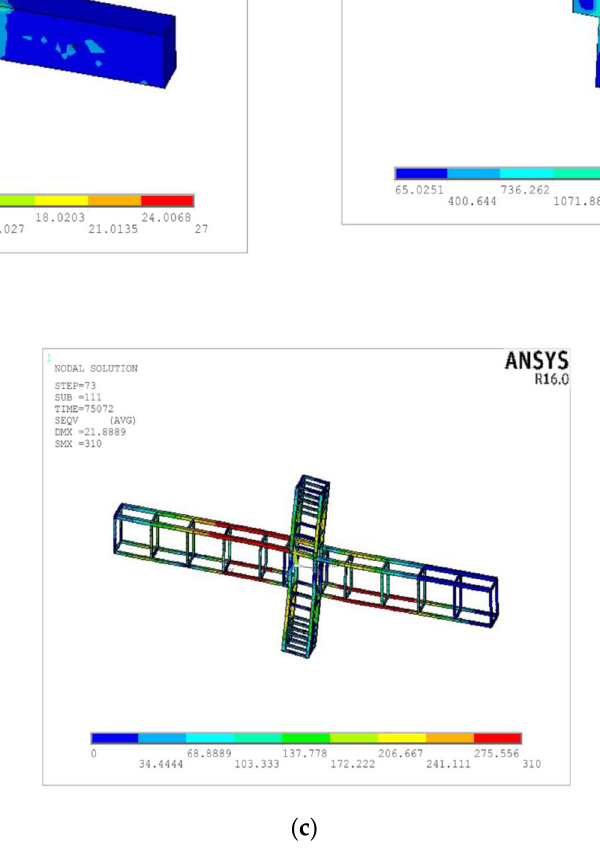
Figure 7. Stress contours for J25FRP1D0 joint (a) concrete, (b) FRP, and (c) Steel.